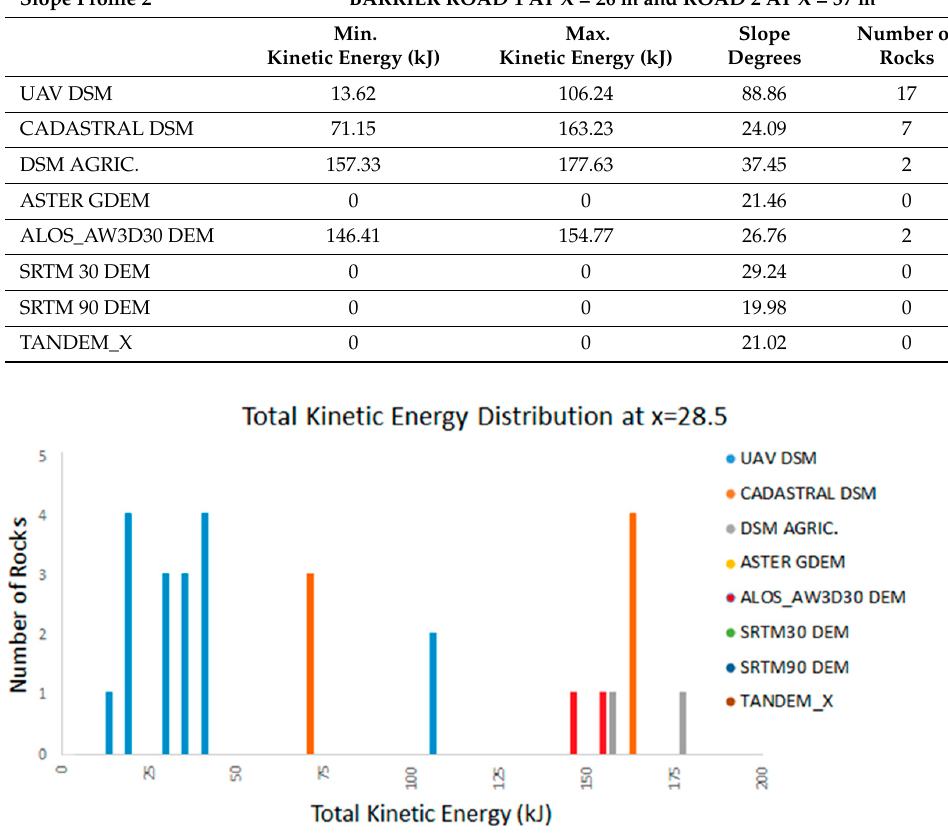
Figure 17. Bounce height for the 2nd slope profile. Table 10. Total kinetic energy distribution at x = 28.5 m for the 2nd slope profile. Bounce height diagrams showed that the rocks in the slope profiles created by ASTER GDEM, SRTM30 DEM, SRTM90 DEM and TanDEM_X mainly rolled or jumped the slope and stopped before the first barrier in horizontal locations less than 26 m. The number of bounces ranged from two to three and the height above slope was between 0.9 m and 2.09 m. On the other hand, in the DSMs with high spatial resolution (UAV DSM, DSM from the Greek Cadastral, DSM from the Ministry of Agriculture and ALOS AW3D30 DEM), the rocks jumped along the slope profile until they reached the end of the slope. The height above slope ranged from 6.79 m to 12.17 m. The maximum number of bounces was rec- orded by the UAV DSM simulation.